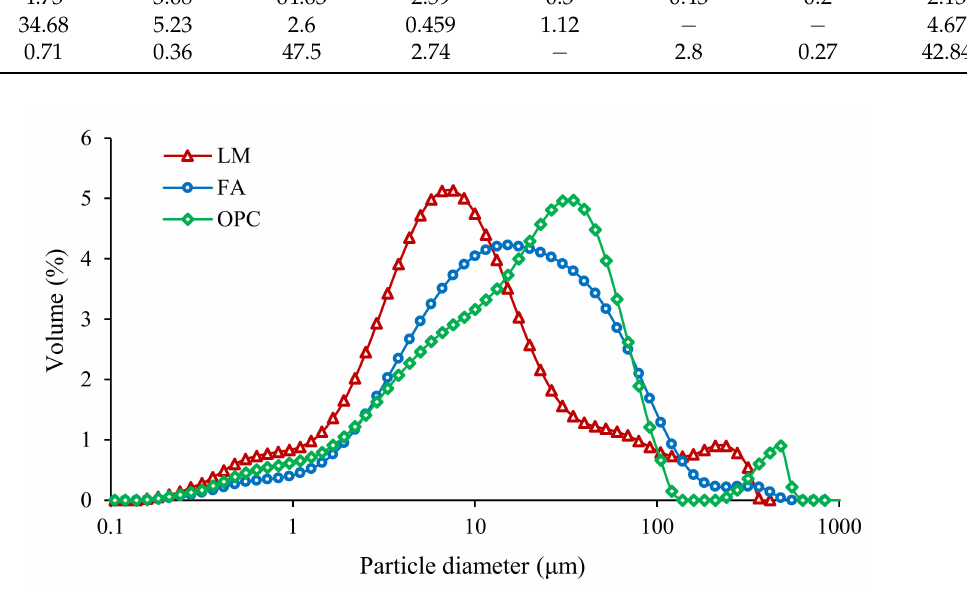
Figure 1. Particle size distribution of LM, FA, and OPC.